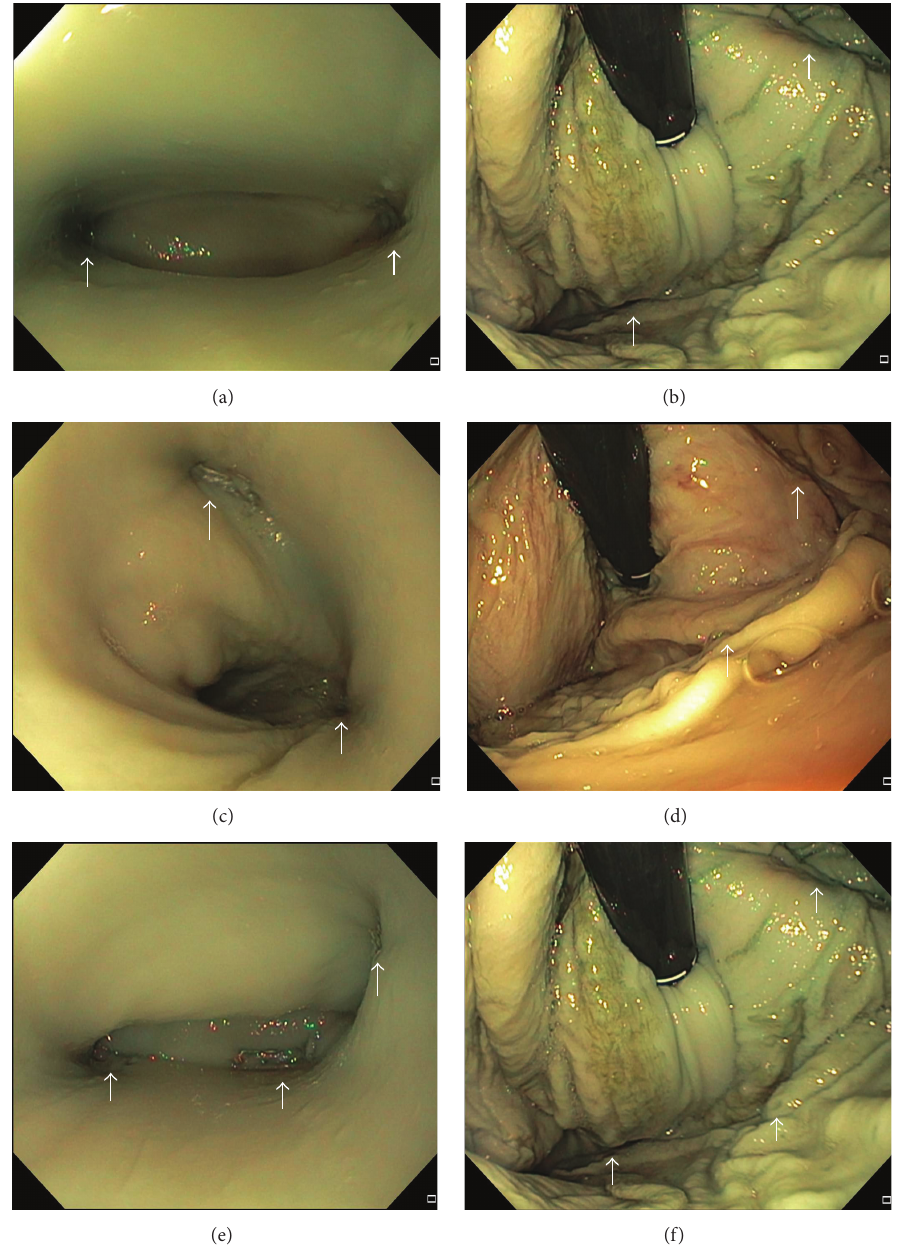
Figure2:Endoscopicimagingfollowingendoscopicfundoplication.Whitearrowsindicatestaplingsite.(a)2stapleswith180 ∘ at3 cmdistance from the GEJ, esophageal view. (b) 2 staples with 180 ∘ at 3cm distance from gastroesophageal junction, retroflexed view. (c) 2 staples with 90 ∘ at 3 cm distance from gastroesophageal junction, esophageal view. (d) 2 staples with 90 ∘ at 3 cm distance from gastroesophageal junction, retroflexed view. (e) 3 staples with 180 ∘ total at 3cm distance from gastroesophageal junction, esophageal view. (f) 3 staples with 180 ∘ total at 3 cm distance from gastroesophageal junction, retroflexed